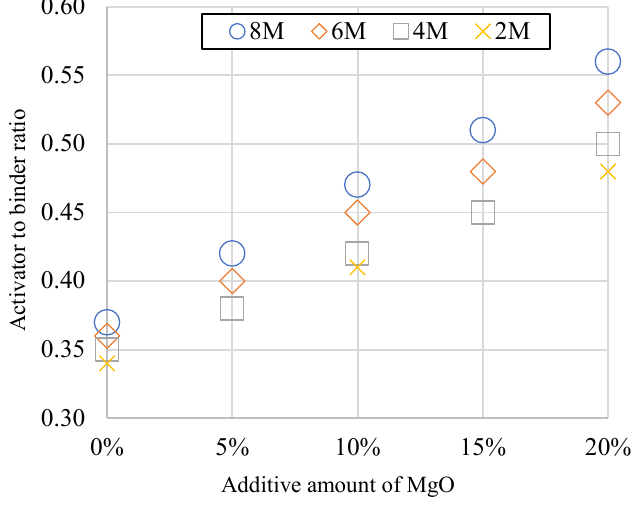
Figure 1. The activator to binder ratios of GP contains different amounts of MgO to make the fluidity of 110 ± 5%.